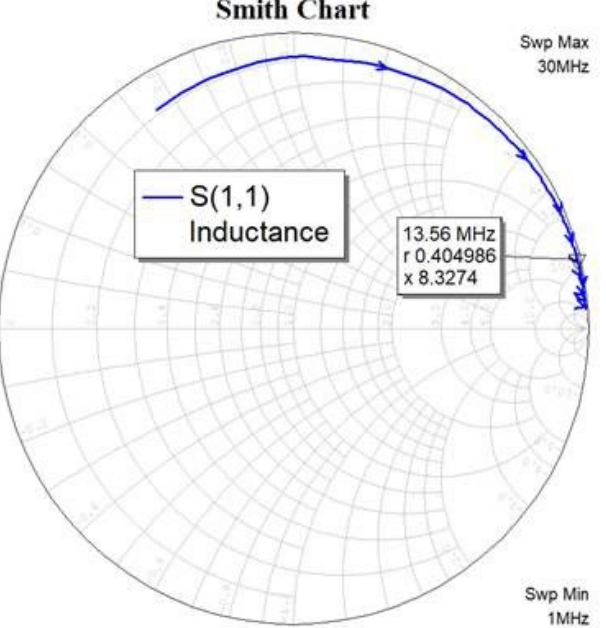
Figure 4. Smith chart and measured impedance for the fabricated flexible PCB antenna at 13.56